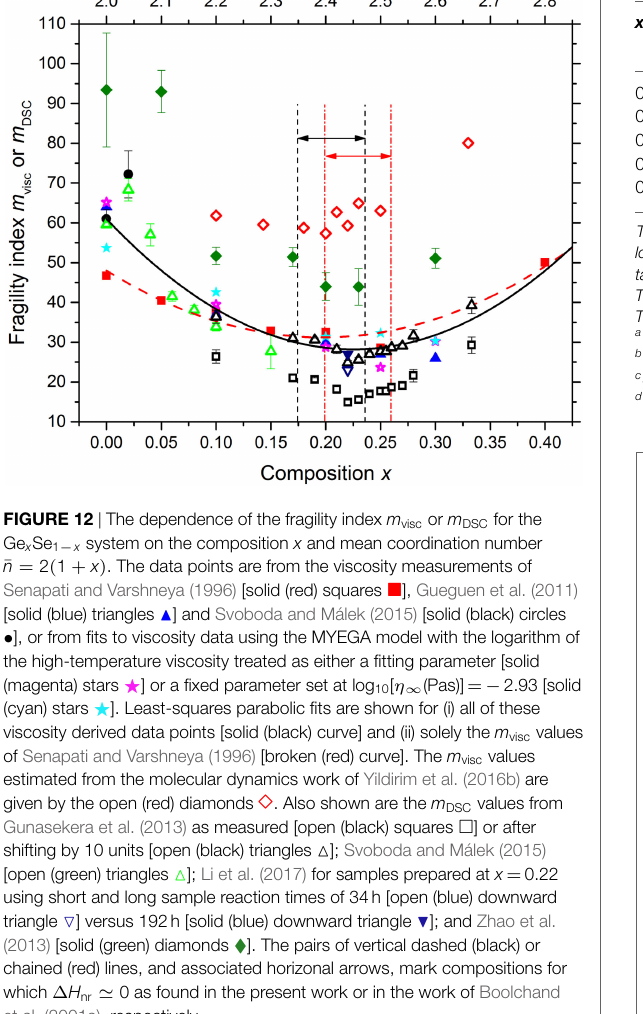
TABLE 1 | The fragility index m visc and glass transition temperature T g,visc corre- sponding to a viscosity (cid:17) ( T g,visc ) = 10 12 Pas. x m visc T g,visc (°C)